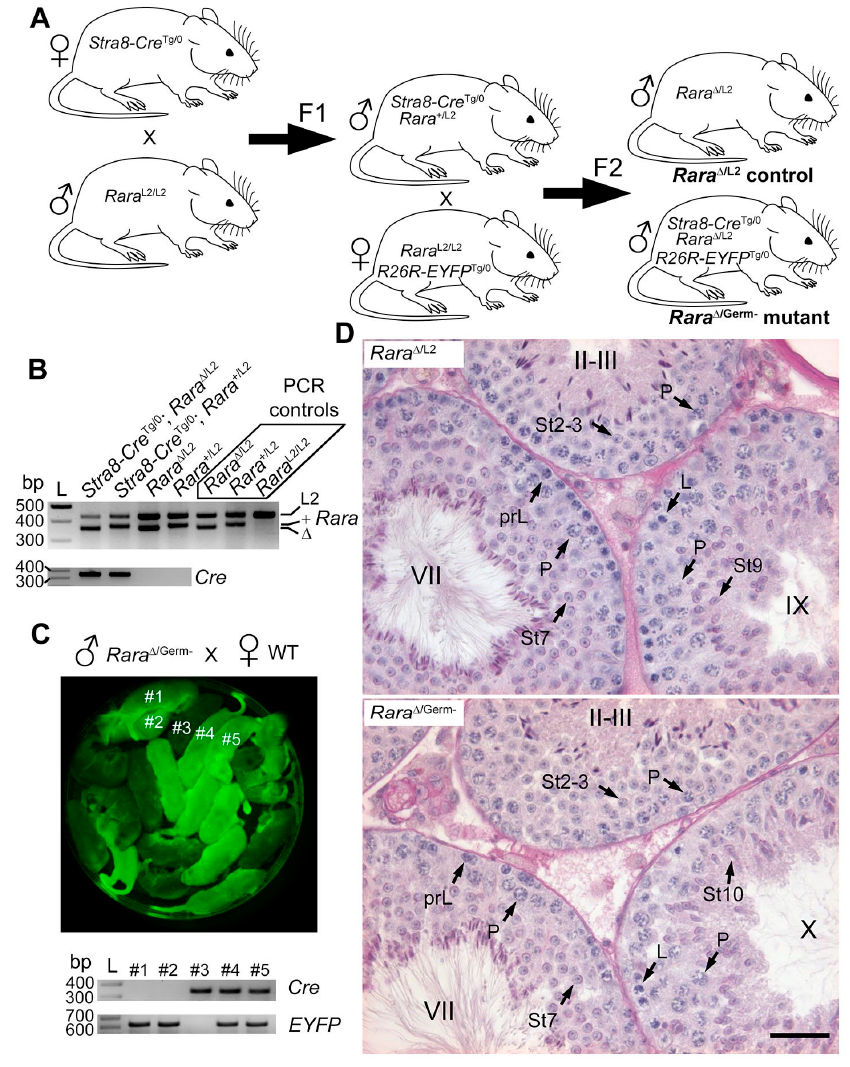
Figure 4. Rara ∆ /Germ − mice display normal spermatogenesis ( A ) Breeding scheme. Stra8-Cre Tg/0 females were crossed with Rara L2/L2 males. This produced Stra8-Cre Tg/0 / Rara +/L2 F1 males, who transmitted either the Rara + or the Rara ∆ allele to their F2 progeny when bred with Rara L2/L2 / R26R-EYFP Tg/0 females. This generated control ( Rara ∆ /L2 ) and mutant ( Rara ∆ /Germ − ) mice in F2. ( B ) Representative PCR analysis of tail DNA from F2 males with the genotypes as indicated. The 427-, 371-, and 357-bp-long fragments correspond to floxed (L2), wild-type (+), and excised ( ∆ ) alleles of the Rara gene, respec- tively (upper panel). Rara ∆ /L2 , Rara +/L2 , and Rara L2/L2 were used as PCR controls, as indicated. An L2 allele, transmitted by the female, was detected in each F2 progeny. The + and ∆ alleles, transmitted by the male, were detected in a mutually exclusive manner. The 350-bp-long fragment corresponds to the Tg(Stra8-cre)1Reb transgene ( Cre , lower panel). L: ladder; bp: base pair. ( C ) Detection of EYFP by ultraviolet light illumination in pups born from a Rara ∆ /Germ − male mated with a wild-type (WT) female (upper panel). EYFP-positive (e.g., #1, #2, #4, and #5) and EYFP-negative (e.g., #3) progenies were obtained in a Mendelian proportion (50%), as expected if almost 100% of germ cells from the father underwent Cre-mediated recombination (i.e., were ablated for the reporter). Representative PCR analysis of tail DNA progenies as indicated. A 350-bp-long fragment corresponds to the Tg(Stra8-cre)1Reb transgene (Cre), and a 620-bp-long fragment corresponds to the Cre-recombined reporter ( EYFP ). ( D ) PAS stains illustrating normal germ cell associations in the seminiferous epi- thelium of 9-month-old control ( Rara ∆ /L2 ) and mutant ( Rara ∆ /Germ − ) testes. Legend: prL, L, and P, pre- leptotene, leptotene, and pachytene spermatocytes, respectively; St2–3 to St10, steps 2–3 to step 10 of spermatid maturation; II–III, VII, IX, and X, epithelial stages. Scale bar: 70 μ m in ( D ).